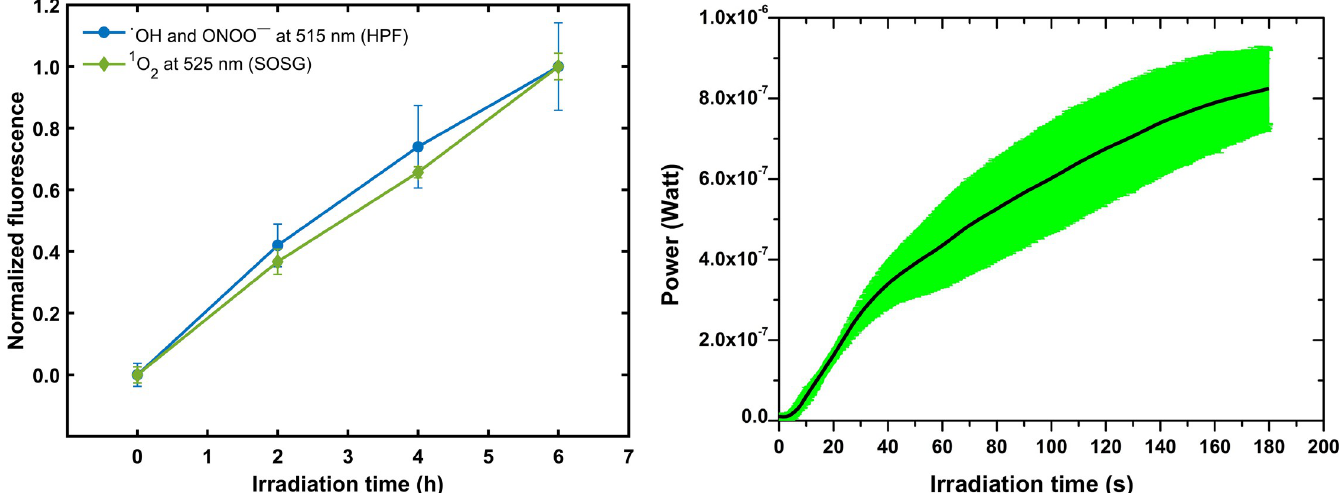
Fig 7. ROS assessment. (A) Fluorescence generated from SOSG (1.92 μ M) and HPF (5 mM ) with pheomelanin nanoparticles, at 525 (green diamonds) and 515 nm (blue circles), respectively. Data are normalized to the maximum value in each case: 3.44x10 6 , and 3.42x10 6 fluorescence units for SOSG and HPF, respectively. The samples were exposed to UVA radiation during 6 hours and evaluated every 2 hours. (B) Power emitted by singlet oxygen during UVA radiation (see section Materials and Methods). The measurements were obtained for 3 minutes. The black line is the average and the band the dispersion of the data from three independent experiments. The large dispersion is due to the detection